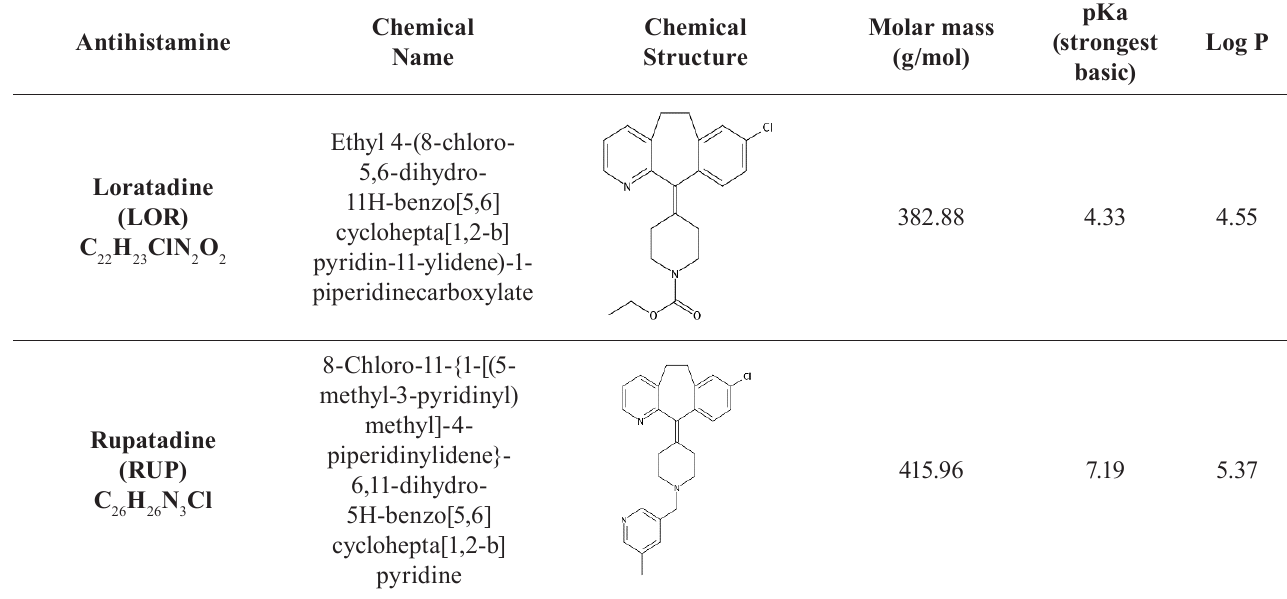
TABLE I - S tructure, identification and predicted properties of antihistamines